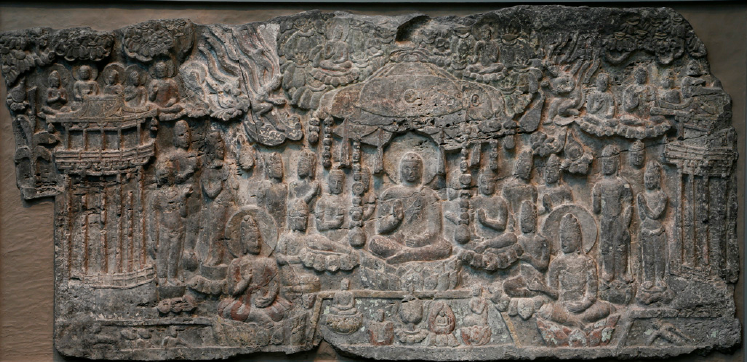
Figure 6. West Pure Land of Amitabha, Xiangtangshan Cave 2, sixth-century Northern Qi (Freer Gallery of Art).